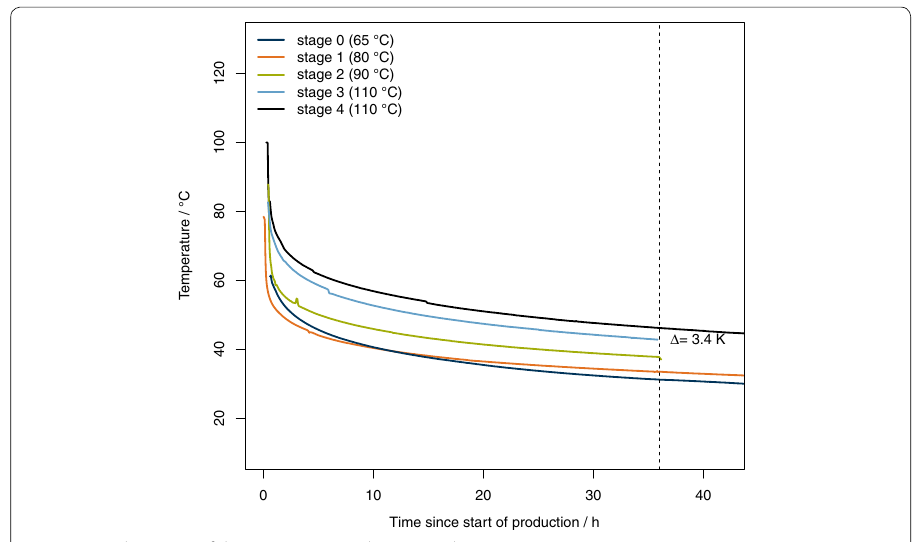
Fig. 6 Development of the temperatures during production stages